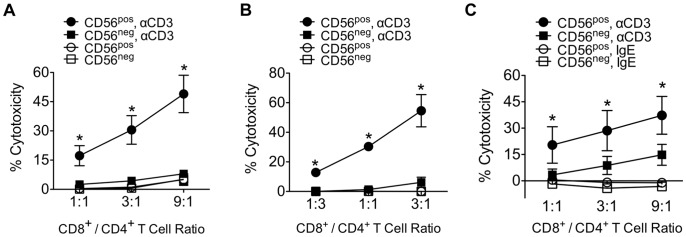
Activated CD56pos cells induce cell death in TCR-activated allogeneic and autologous CD4 T cells.(A) Suppression of activated allogeneic clonal CD4 T cells by CD8 Treg (CD56pos) cells. CD56pos and CD56neg cells isolated from healthy donors were stimulated with PHA and expanded for 7–9 days. Suppression assays were performed as described in Materials and Methods. (CD56pos, αCD3), the suppressive activity of CD8 Treg towards CD3-activated S2B5 cells; (CD56neg, αCD3), the suppressive activity of CD8 Tcon towards CD3-activated S2B5 cells; (CD56pos), the suppressive activity of CD8 Treg towards non-activated S2B5 cells; (CD56neg), the suppressive activity of CD8 Tcon towards non-activated S2B5 cells. *p<0.05. Results are pooled from three healthy donors (n = 3). p values were calculated with unpaired two-tailed Student’s t-test compared to (CD56neg, αCD3). Mean and standard deviation are shown. (B) Activated CD8 Treg induce lysis of TCR-activated autologous polyclonal CD4 T cells. Isolated CD8 Treg (CD56pos) and CD8 Tcon (CD56neg) were stimulated with PHA and expanded for 8–15 days. Isolated autologous polyclonal CD4 T cells were stimulated with PHA and expanded for 8 days. Suppression assays were performed as described in Materials and Methods. (CD56pos, αCD3), the suppressive activity of CD8 Treg towards pre-activated autologous CD4 T cells; (CD56neg, αCD3), the suppressive activity of CD8 Tcon towards pre-activated autologous CD4 T cells; (CD56pos), the suppressive activity of CD8 Treg towards non-activated autologous CD4 T cells; (CD56neg), the suppressive activity of CD8 Tcon towards non-activated autologous CD4 T cells. *p<0.05. Results are pooled from two independent sorting experiments. P values were calculated with unpaired two-tailed Student’s t-test compared to (CD56neg, αCD3). Mean and standard deviation are shown. (C) Activated CD8 Treg induce lysis of TCR-activated allogeneic polyclonal CD4 T cells. Isolated CD56pos and CD56neg cells were stimulated with PHA and expanded for 8–15 days. Isolated allogeneic polyclonal CD4 T cells were stimulated with PHA and expanded for 8–10 days. Suppression assays were performed as described in Materials and Methods. (CD56pos, αCD3), the suppressive activity of CD8 Treg towards pre-activated allogeneic polyclonal CD4 T cells; (CD56neg, αCD3), the suppressive activity of CD8 Tcon towards pre-activated allogeneic polyclonal CD4 T cells; (CD56pos, IgE), the suppressive activity of CD8 Treg towards isotype control mouse IgE-treated allogeneic polyclonal CD4 T cells; (CD56neg, IgE) the suppressive activity of CD8 Tcon towards isotype control mouse IgE-treated allogeneic polyclonal CD4 T cells. *p<0.05. Results are pooled from six healthy donors (n = 6). p-values were calculated with unpaired two-tailed Student’s t-test compared to (CD56neg, αCD3). Mean and standard deviation are shown.